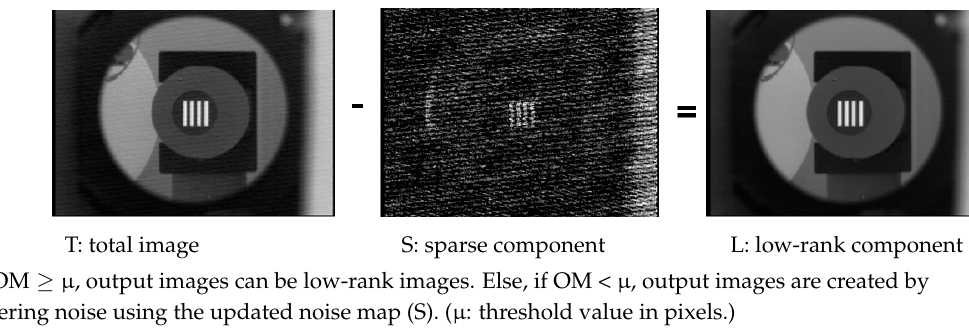
Figure 4. Block diagrams of proposed BRANF algorithm.